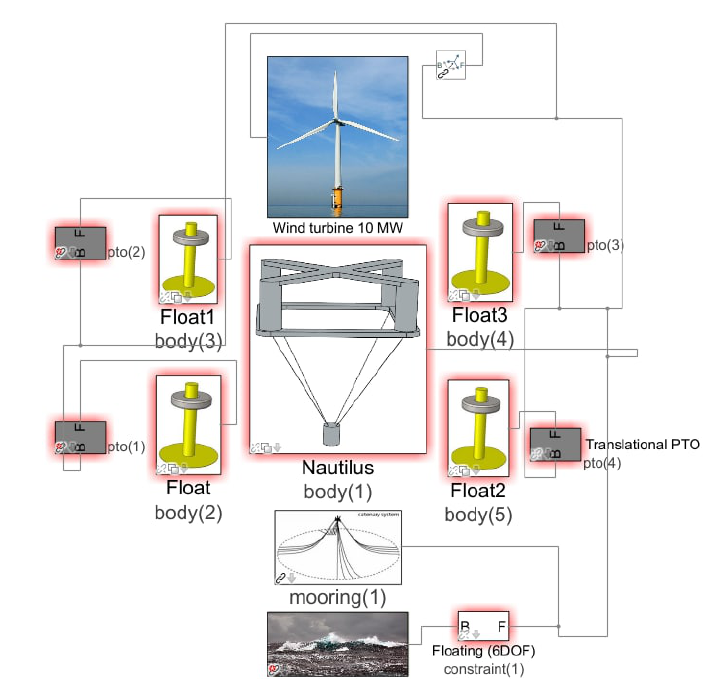
Figure 8. Numerical model of the hybrid wind and wave system.